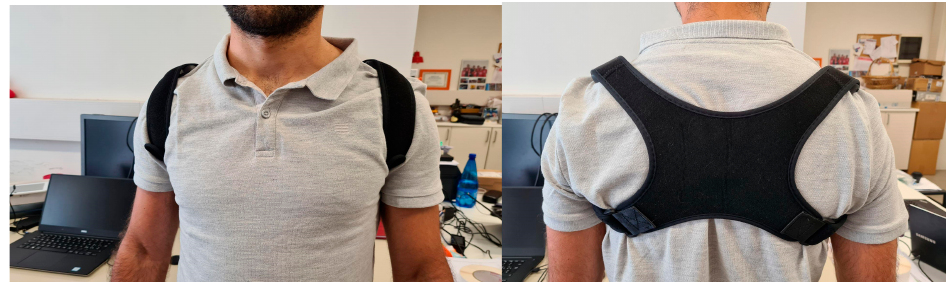
Figure 7. Second smart harness solution positioning SWs on shoulders and back.